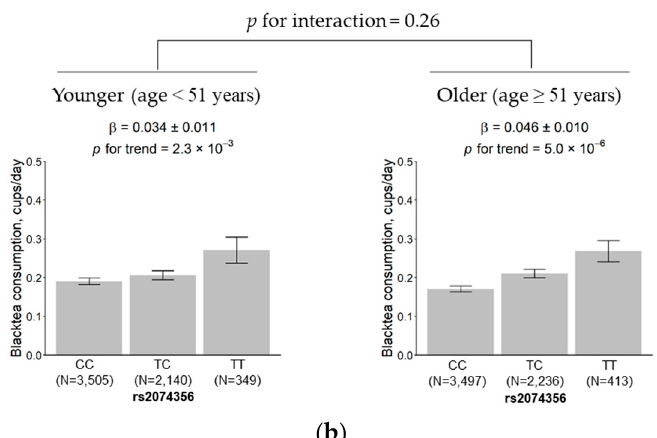
Figure 4. Effects of rs2074356 on habitual black tea consumption stratified by sex ( a ) and age ( b ). The black tea consumption is marked for each allele, CC, TC, and TT, for rs2074356. Error bars and β indicate the standard deviation and the estimated regression coefficient, respectively.